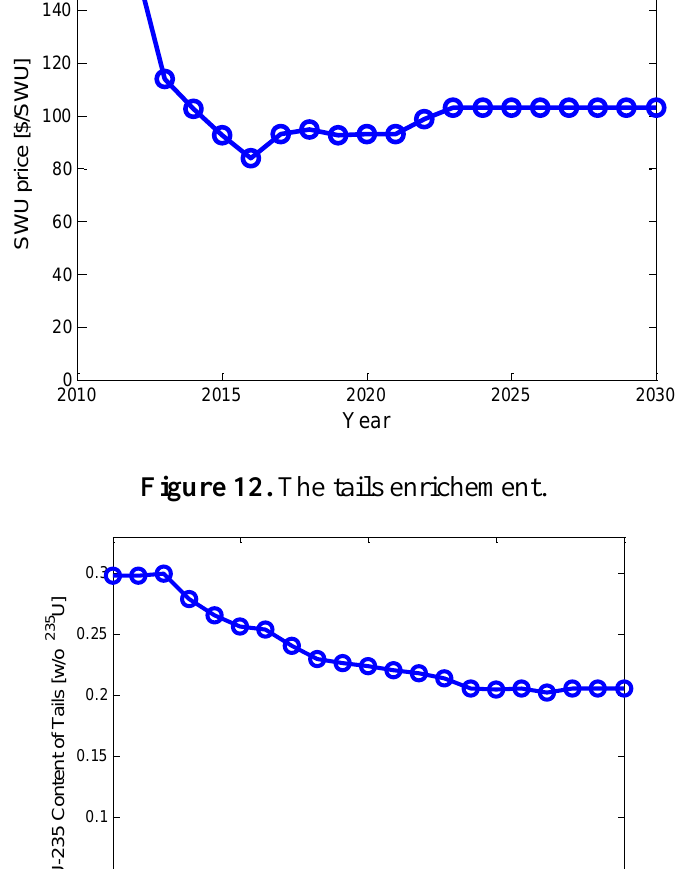
Figure 11. SWU price.